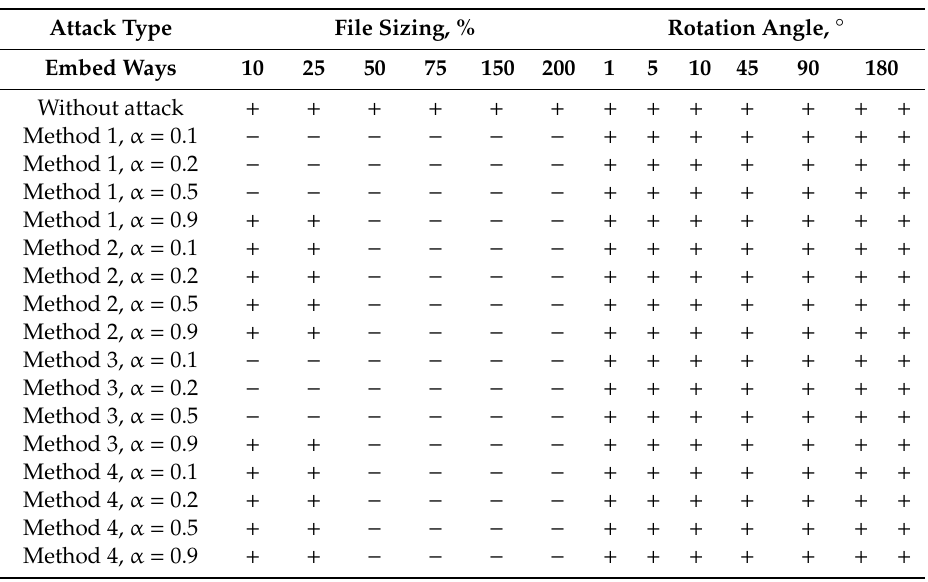
Table 1. The results of the experiments carried out on the attacks to verify the e ff ectiveness of the method on the example of the test image “Lena” by Equation (34) for the parameters m = 1, n = 7.